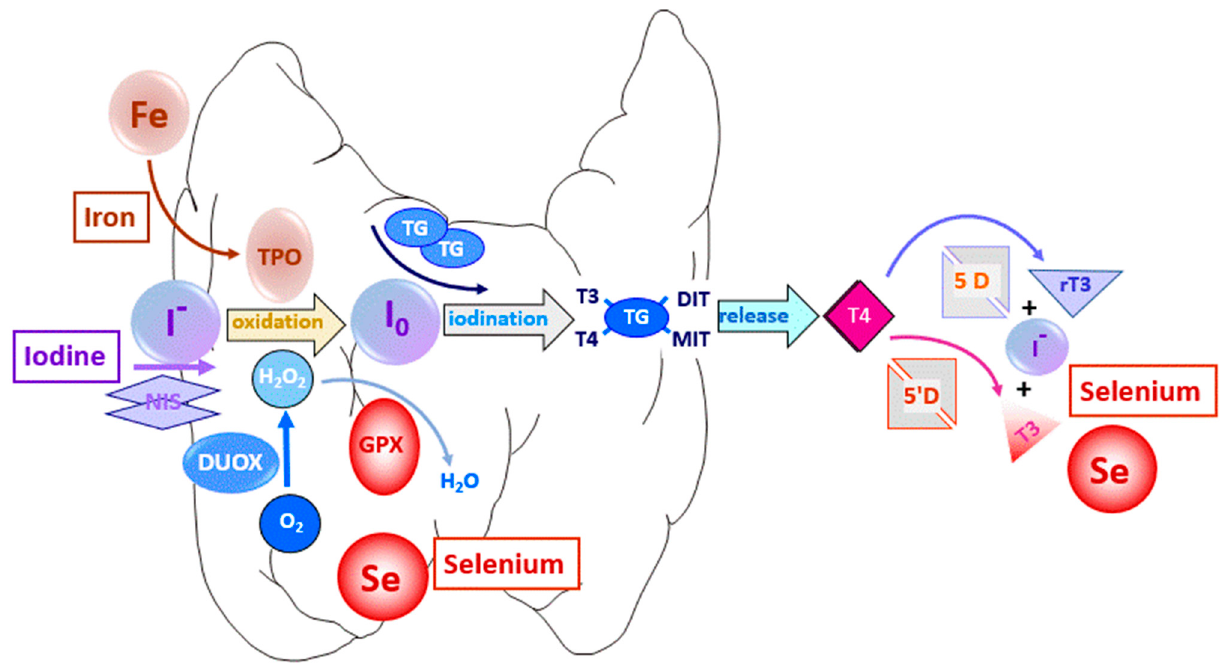
Figure 1. Essential role of the three trace elements iodine, selenium and iron in thyroid hormone biosynthesis and activation. Abbreviations: NIS: Na + -Iodide-Symporter (iodide uptake); DUOX: dual oxidase (H 2 O 2 generation); TPO: thyroperoxidase (hemoprotein); TG: thyroglobulin (synthesis and storage protein); GPX: glutathione peroxidase (antioxidant defense); DIO: deiodinase (TH in- /activation).